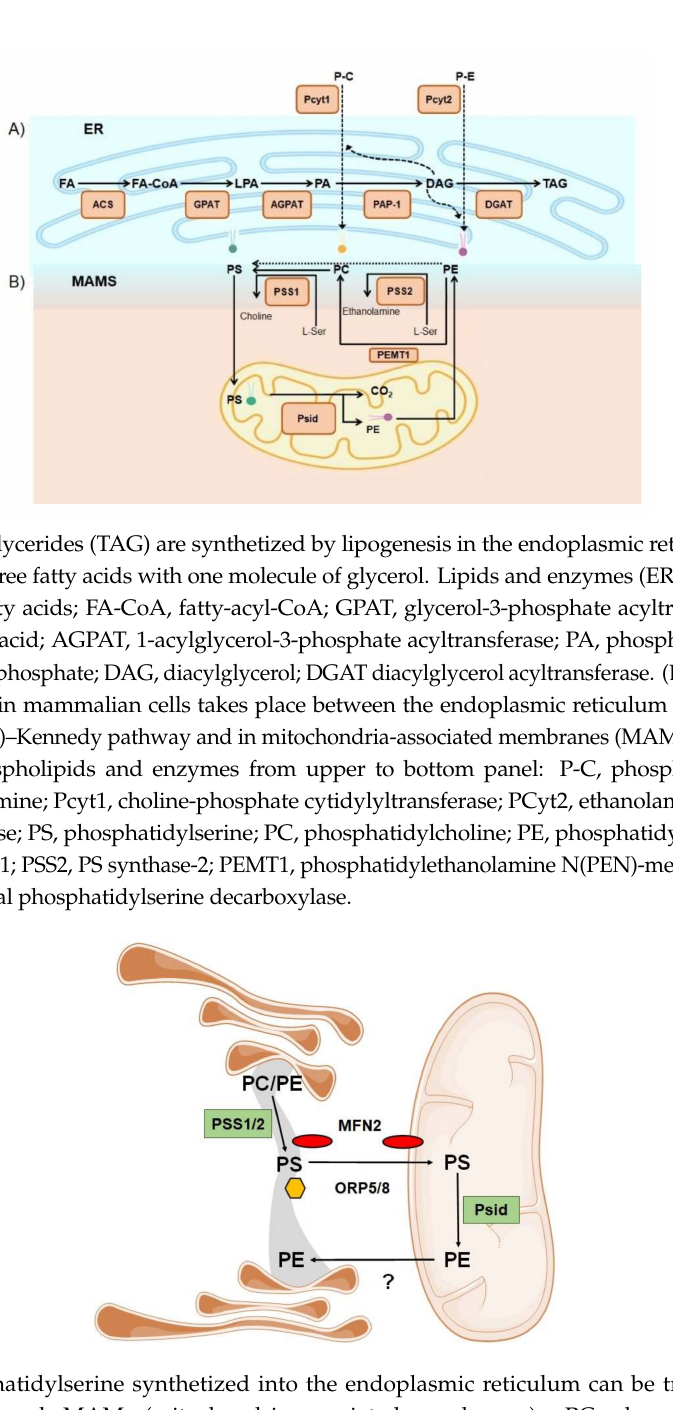
Figure 2. Phosphatidylserine synthetized into the endoplasmic reticulum can be transferred into mitochondria through MAMs (mitochondria-associated membranes). PC, phosphatidylcholine; PE, phosphatidylethanolamine; PS, phosphatidylserine; MFN2, mitofusin 2; ORP5 / 8, oxysterol-binding protein-related protein 5 /